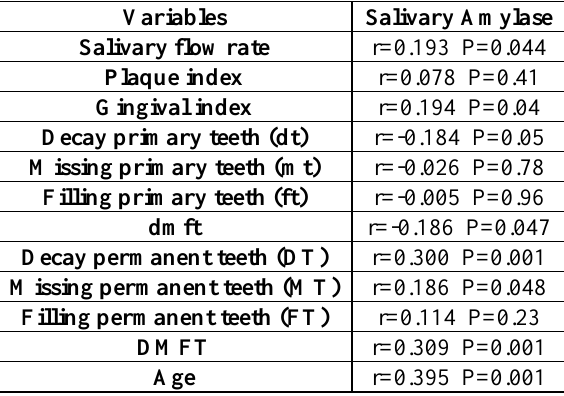
Table 2: Linear correlation coefficient test